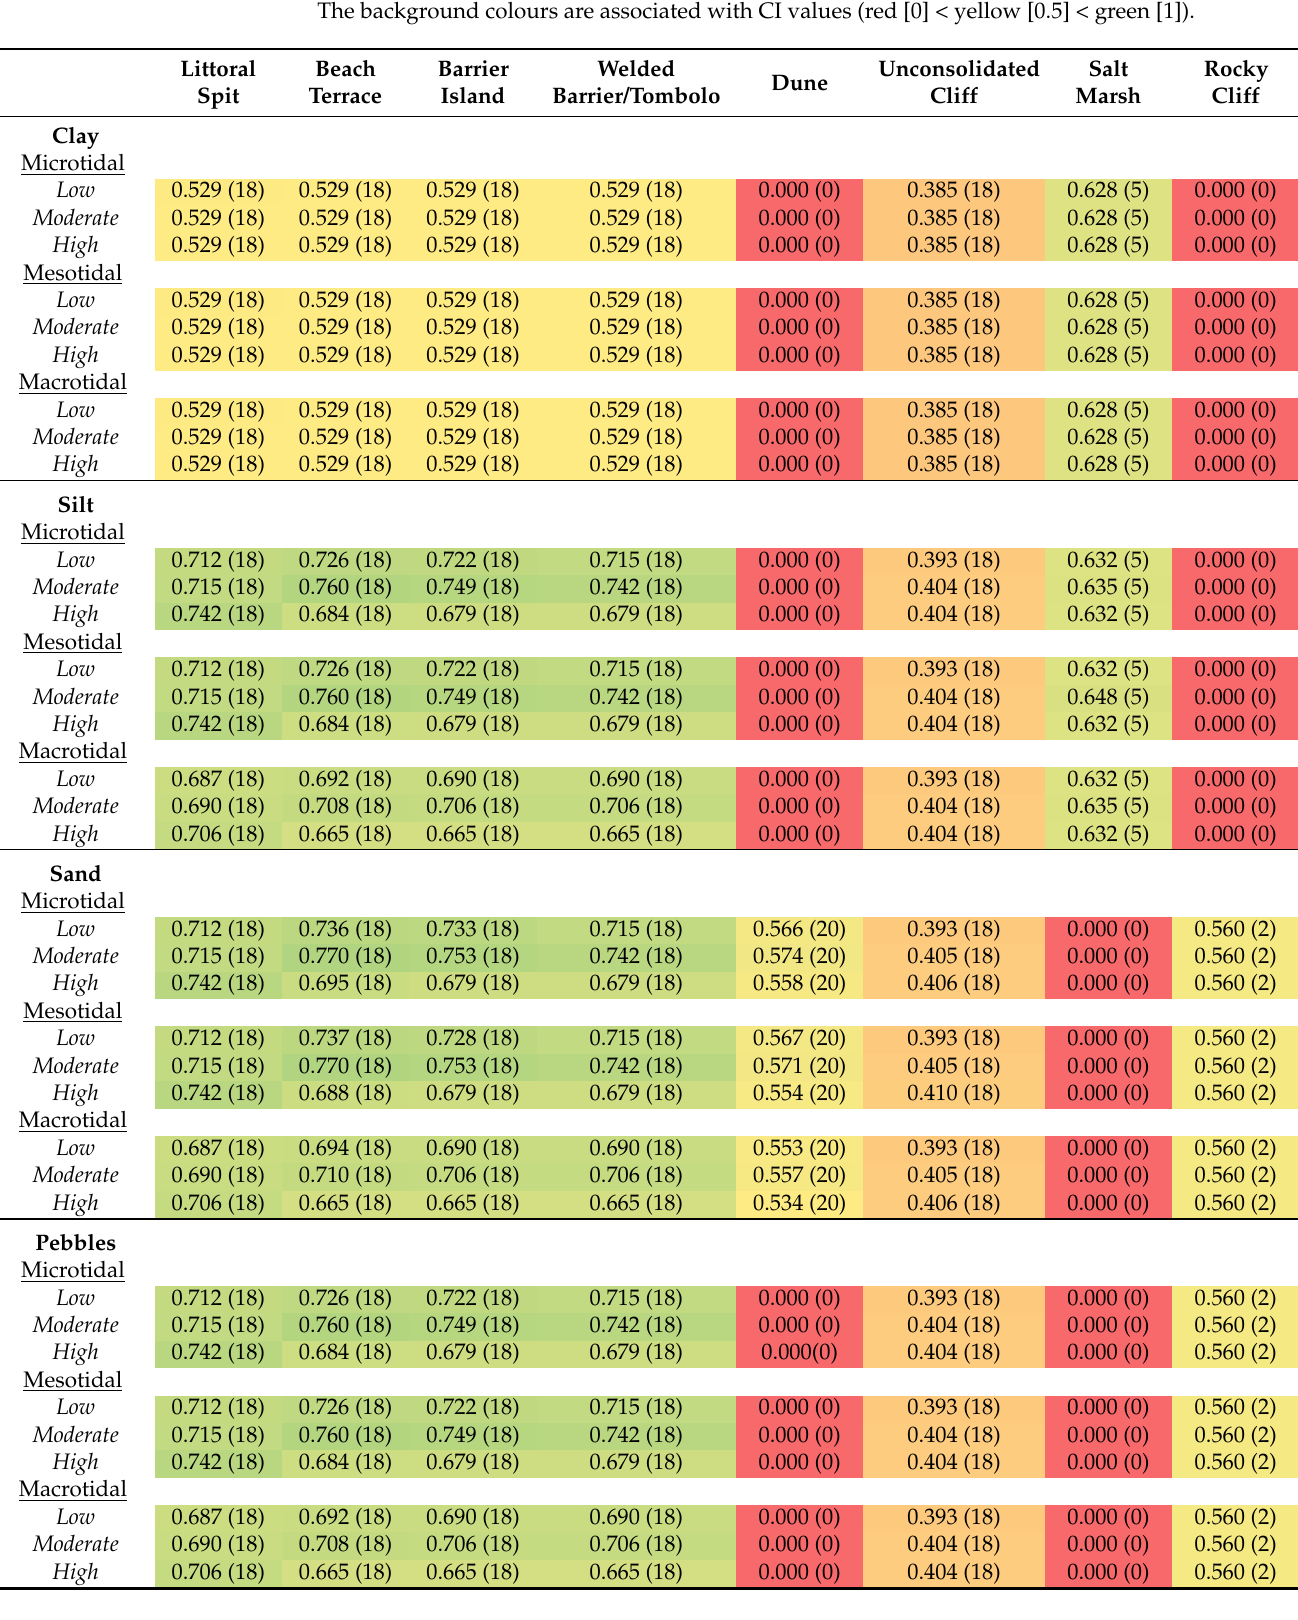
Table 12. Average correspondence index (CI) and number of CDMs evaluated (CI (nb.CDM)) for each group of environmental features (type of coast, type of substrate, tidal range, and wave